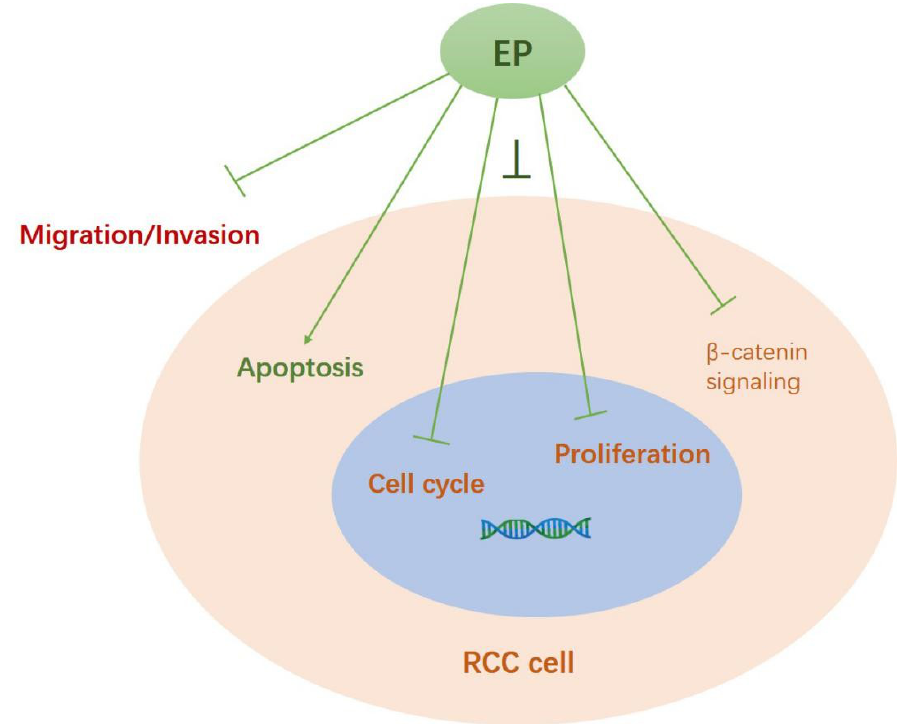
Figure 6. Summarized diagram of the mechanisms underlying EP’s anti-RCC role. EP exerted anti-cancer effects via multiple mechanisms, including inhibiting cell proliferation, attenuating migration/invasion, inducing apoptosis, arresting cell cycles, and suppressing β-catenin signaling.